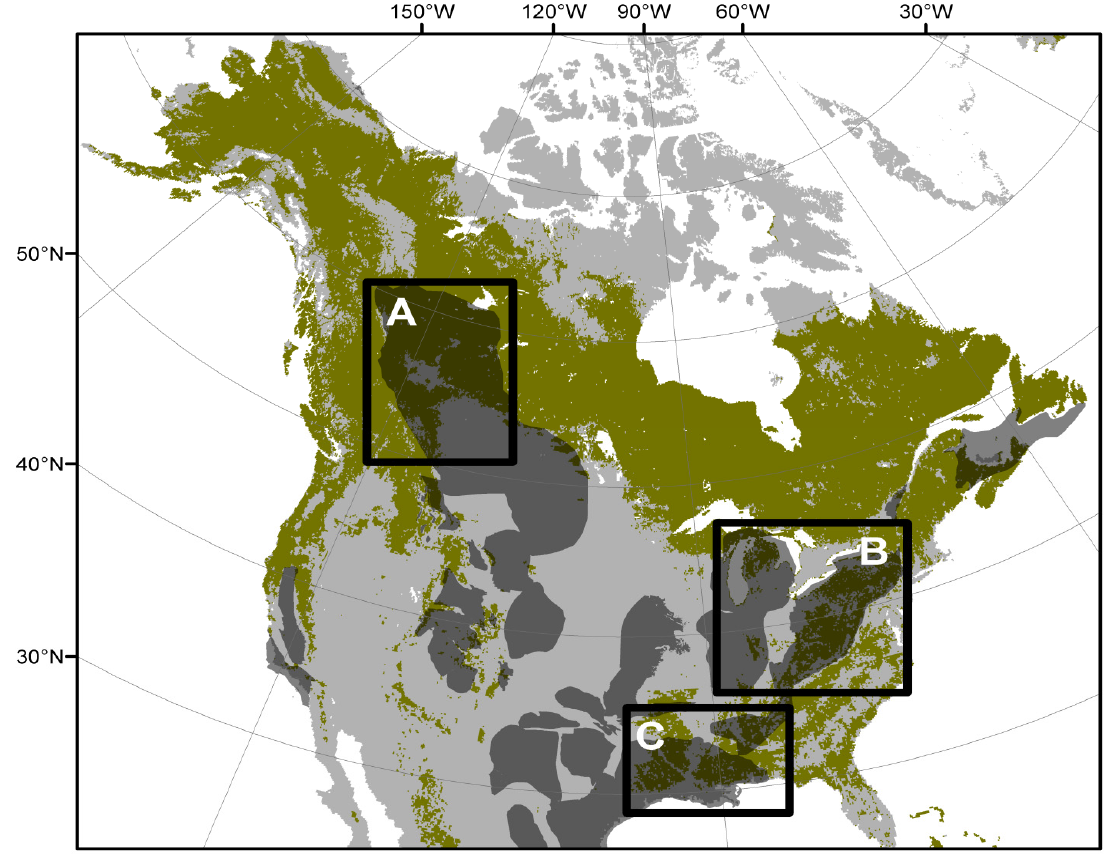
Figure 2. The coincidence of North American forest cover (green) and major underlying hydrocarbon basins (transparent gray). Black boxes bound forested regions currently undergoing rapid energy development: ( A ) oil sands in Alberta, Canada; ( B ) Marcellus and Antrim shale basins in Northeastern U.S.; and ( C ) the Gulf of Mexico oil and gas basin in Southeastern